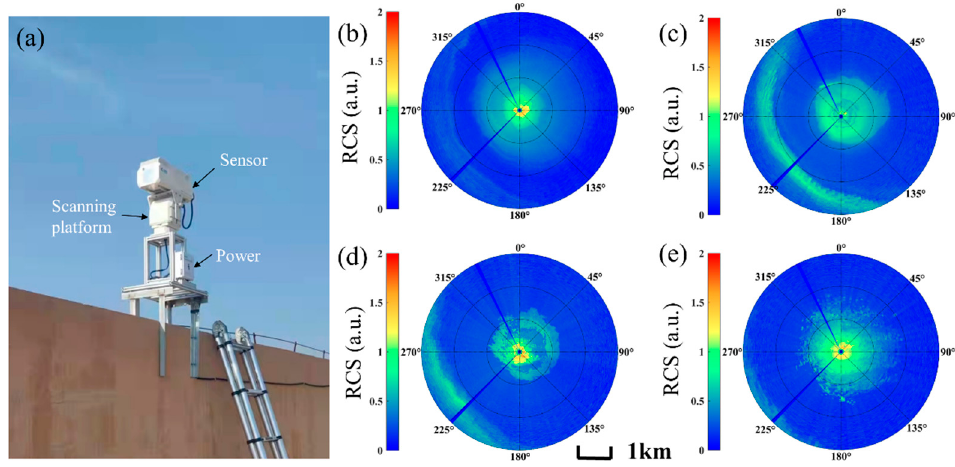
Figure 12. ( a ) Photo of mIRLidar system and RCS maps (3 km radius) in scan mode at different times on 17 March 2022, in Zibo (UTC+8): ( b ) 06:00~06:30, ( c ) 06:30~07:00, ( d ) 07:00~07:30 and ( e ) 07:30~08:00.